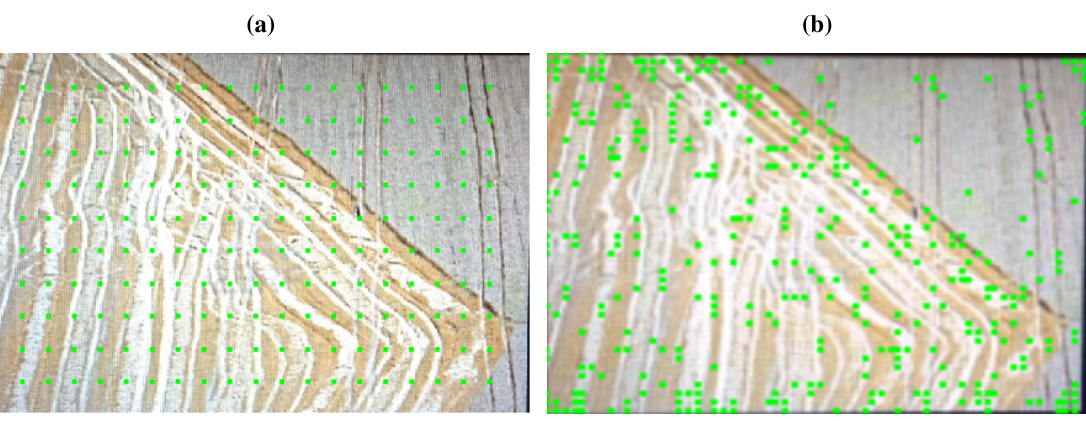
Figure 2. Selection of features for optical flow calculations based on two different methods. In (a) a homogeneous spaced grid of pixels is shown, in (b) a selected grid of pixels based on 9 point FAST feature detection is